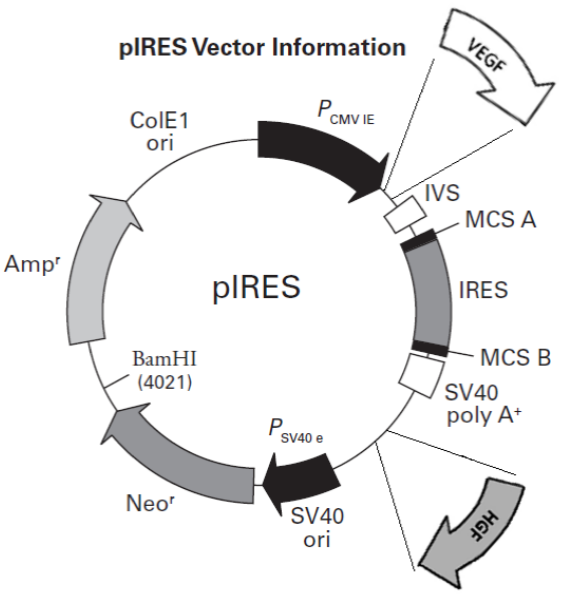
Figure 1. Schematic representation of the plasmids used with the two cloned transcription factor genes used for gene therapy (VEGF and